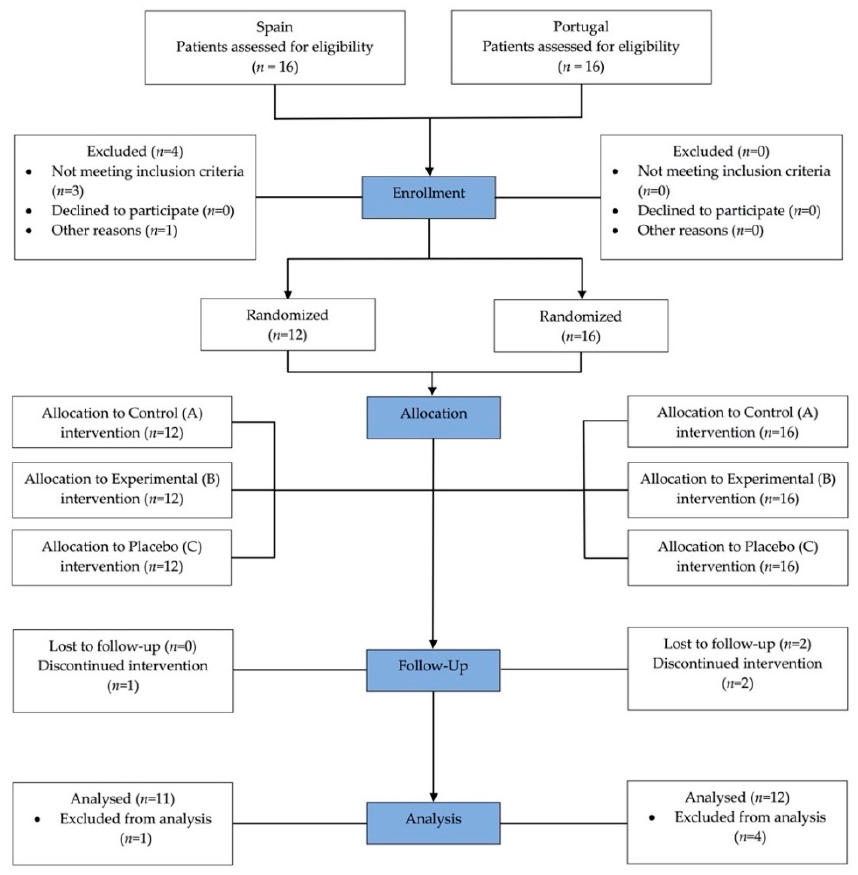
Figure 1. Flowchart diagram of the study protocol according to The Consolidated Standards of Reporting Trials (CONSORT) guidelines [25].